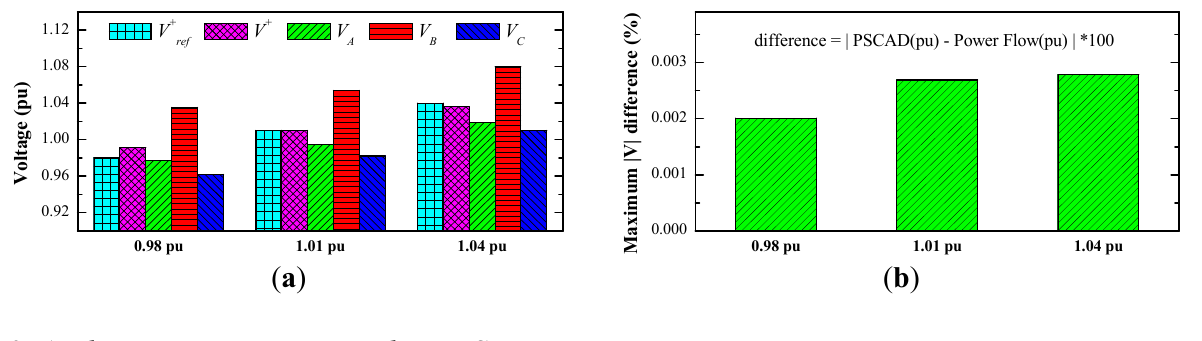
Figure 10. Results for the voltage control-mode DG: ( a ) reference voltage and voltages measured in the PSCAD model and ( b ) maximum voltage magnitude